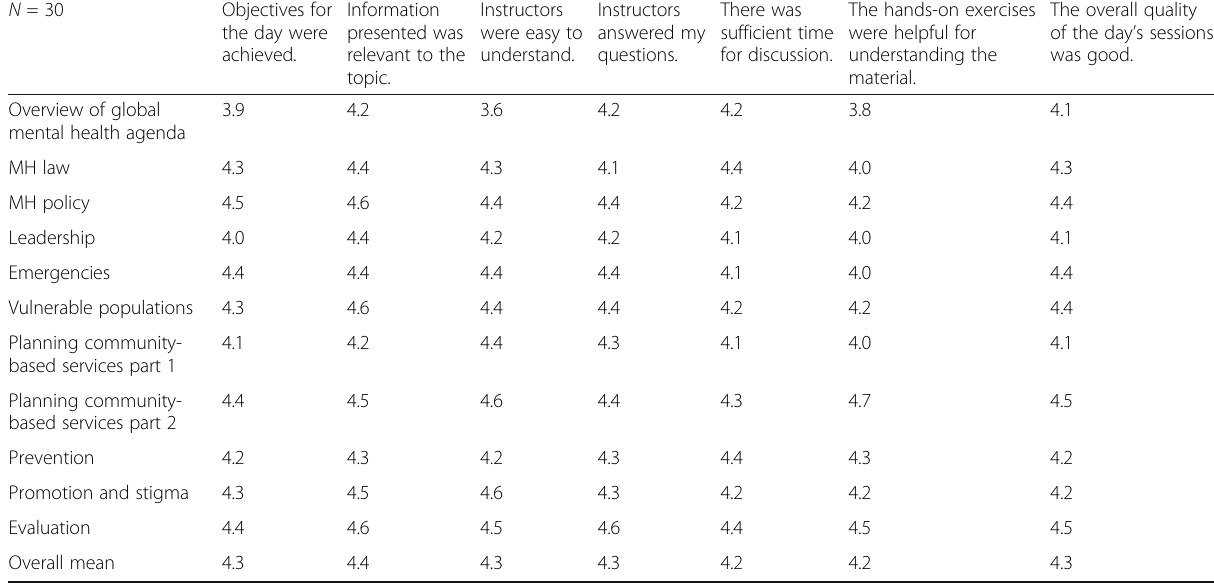
Table 2 Module evaluation